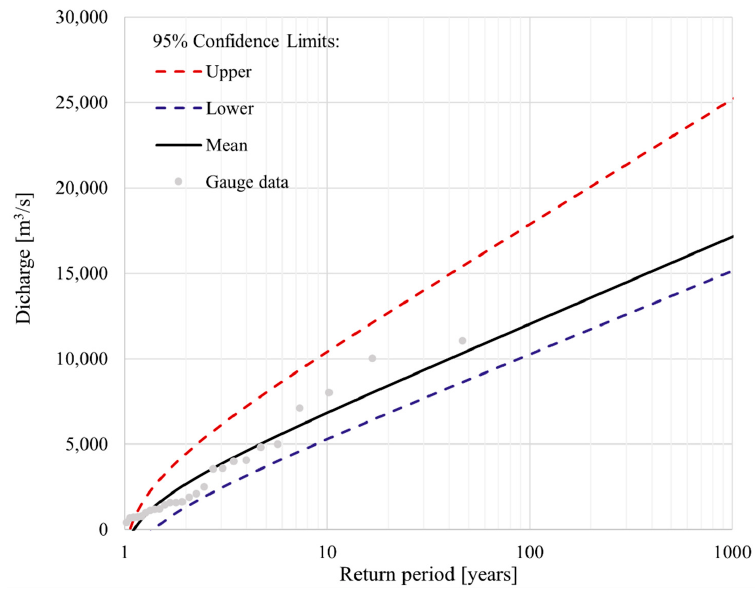
Figure 4. Flood frequency curve for the Tagus River at Tramagal river gauge.